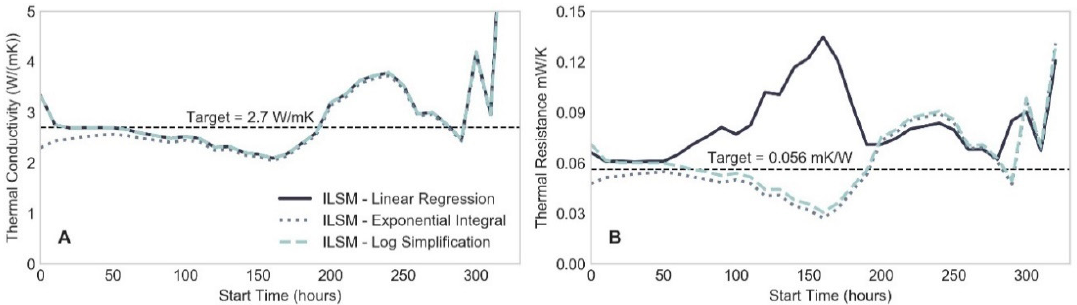
Figure 9. Step-wise fitting of the infinite line source model (ILSM) giving the change in ( A ) 𝝀 𝒈 and ( B ) 𝑹 𝒃 over 100 hours sliding windows of the test data.